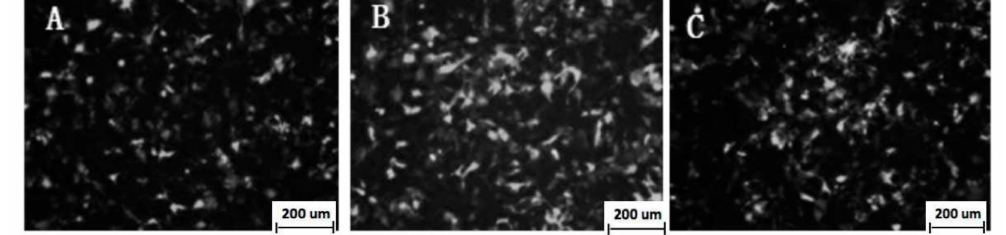
Figure 3. Green fluorescent protein (GFP) fluorescence protein expression in the HEK293 cells ( A : 24 h; B : 48 h; C : 72 h).